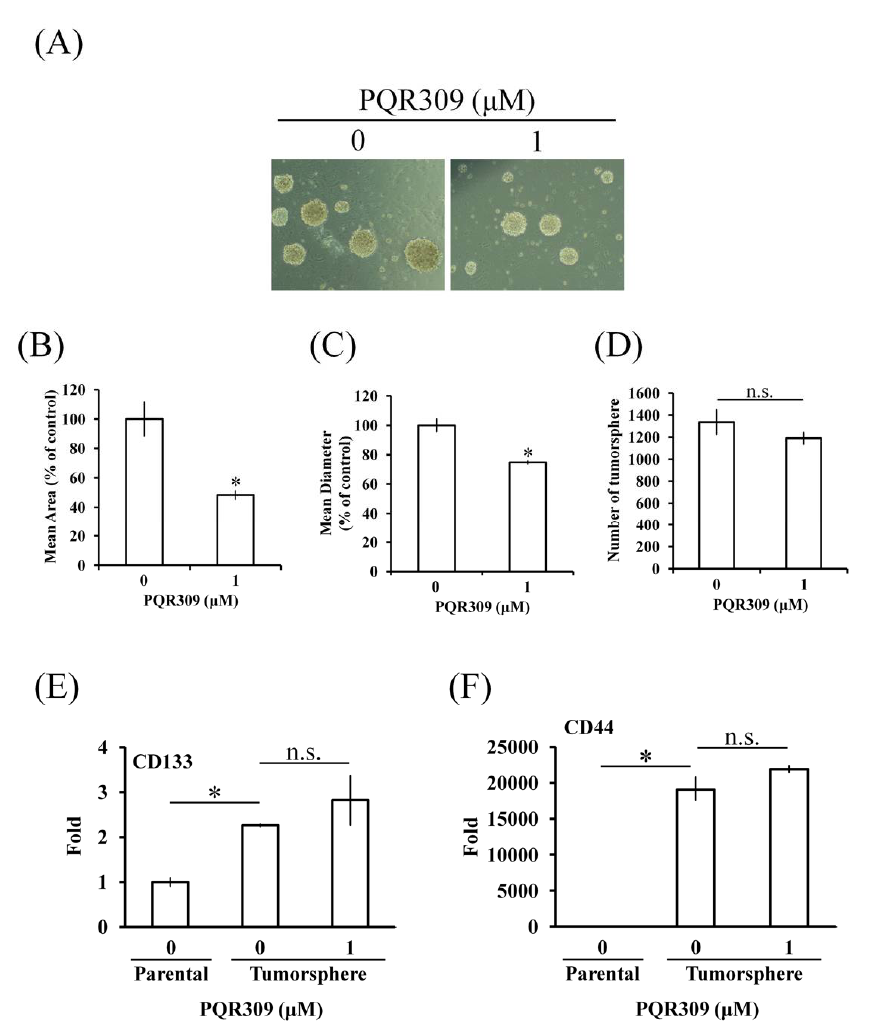
Figure 3. Effect of PQR309 on tumorsphere formation in AN3CA cells. ( A ) Cancer stem cells of AN3CA (2 × 10 4 cells/well of a 6-well plate) from the first tumorsphere were seeded in the sphere formation medium with or without 1 μM PQR309. After 14 days, the spheres were investigated under an inverted microscope. ( B , C ) The area and diameter of spheres were analyzed by Software ImageJ. ( D ) The spheres were counted under an inverted microscope. Total RNA was collected from spheres after treating with PQR309 (0 and 1 μM) for 14 days. RT-qPCR was performed to analyze the mRNA expressions of ( E ) CD133 and ( F ) CD44. The ratio of parental AN3CA cells without treatment was set at 1. The symbol ∗ indicates p < 0.05. “n.s.” indicates no significance ( p > 0.05).